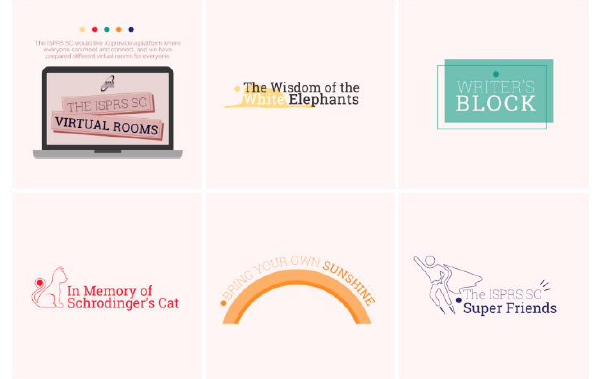
Figure 1 . The Virtual Rooms hosted in April 2020 featured five different rooms.